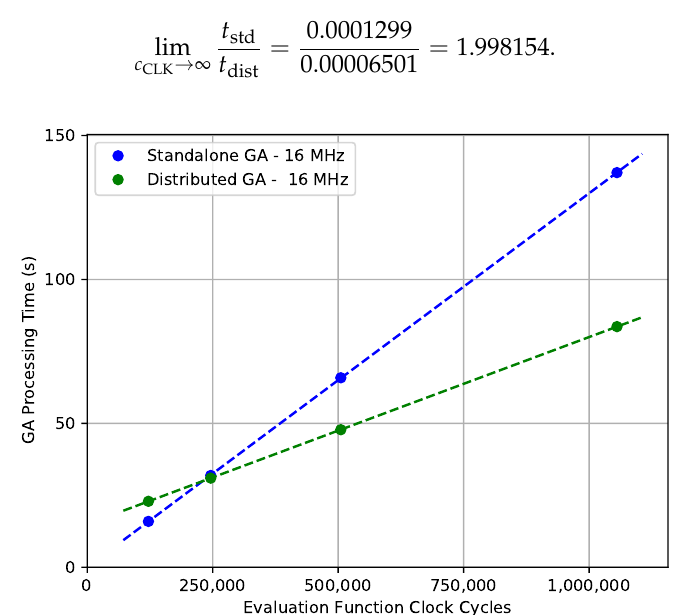
Figure 21. Comparison of standalone GA (1 node) and distributed GA (2 nodes) processing time with same clock